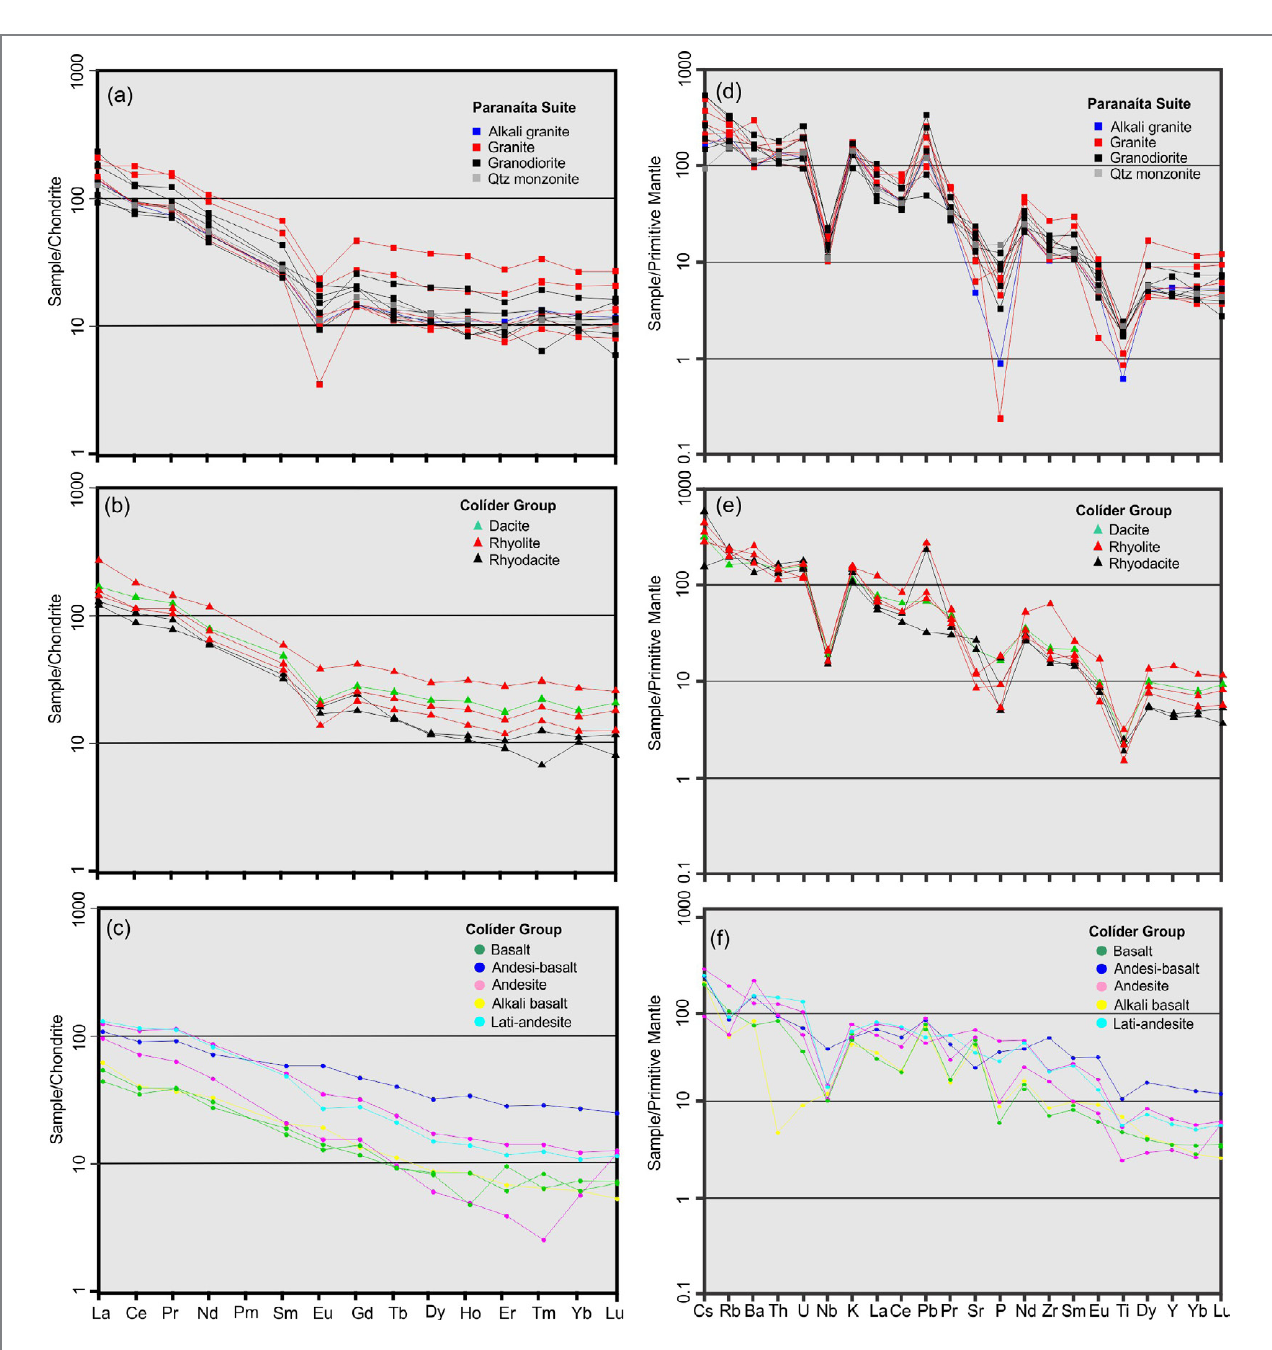
FIGURE 6 - Chondrite-normalized rare earth elements (REE) diagram (Nakamura 1974) of acid rocks from the Paranaíta Intrusive Suite (a), Colíder Group (b) and of the basic rocks from the Colíder Group (c); Primitive mantle-normalized trace element (LILE and HFSE) spidergram (Sun and McDonough 1989) for the Paranaíta Intrusive Suite (d), Colíder Group (e) and Colíder Group basic rocks